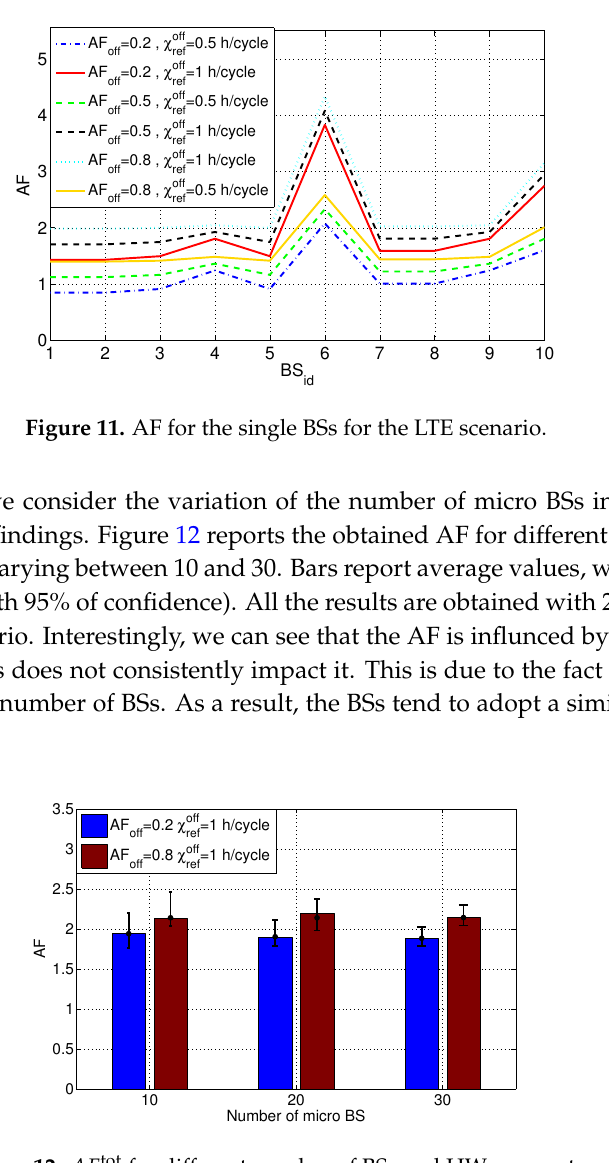
Figure 12. AF tot for different number of BSs and HW